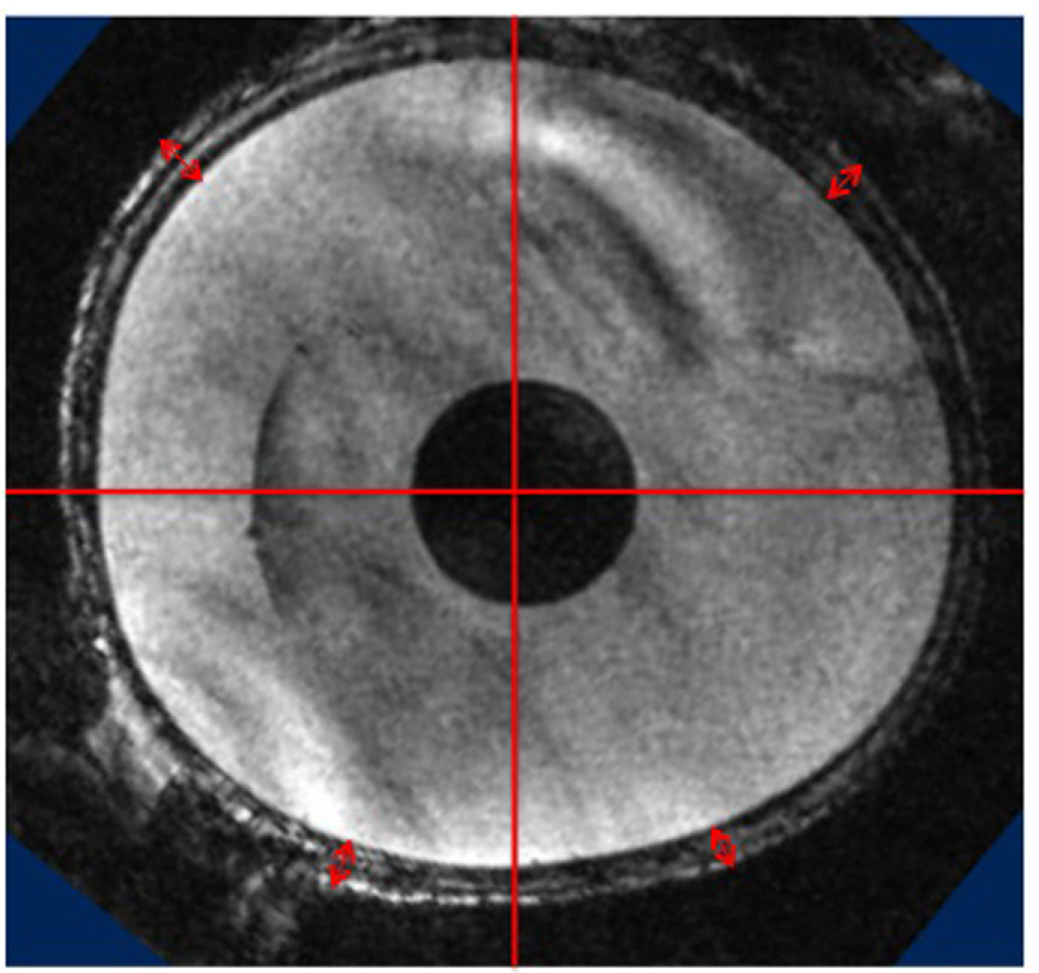
Fig 2. Example picture of MR image in axial plane utilized for thickness measurements. Measurements were performed in each quadrant from the shell of the implant to the outer side of the skin (red arrows). Scale was set with means of the inner circle that had the standardized diameter of 0.8 centimeter. (Fig 5, yellow line). This measurement site equates to the measurement site of the MRI. All